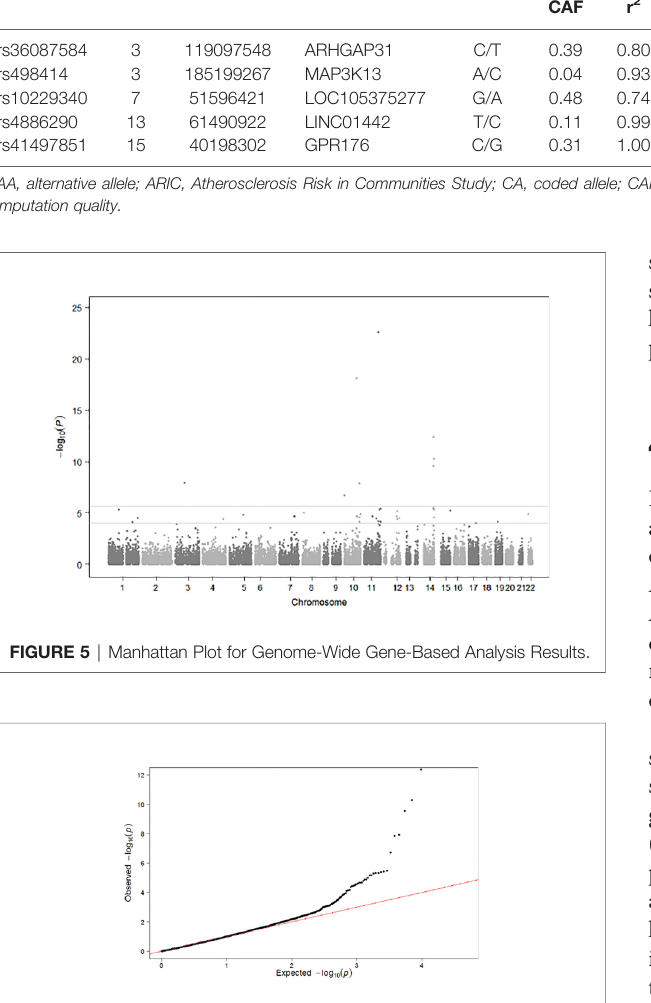
FIGURE 6 | QQ Plot for Gene-Based Analysis